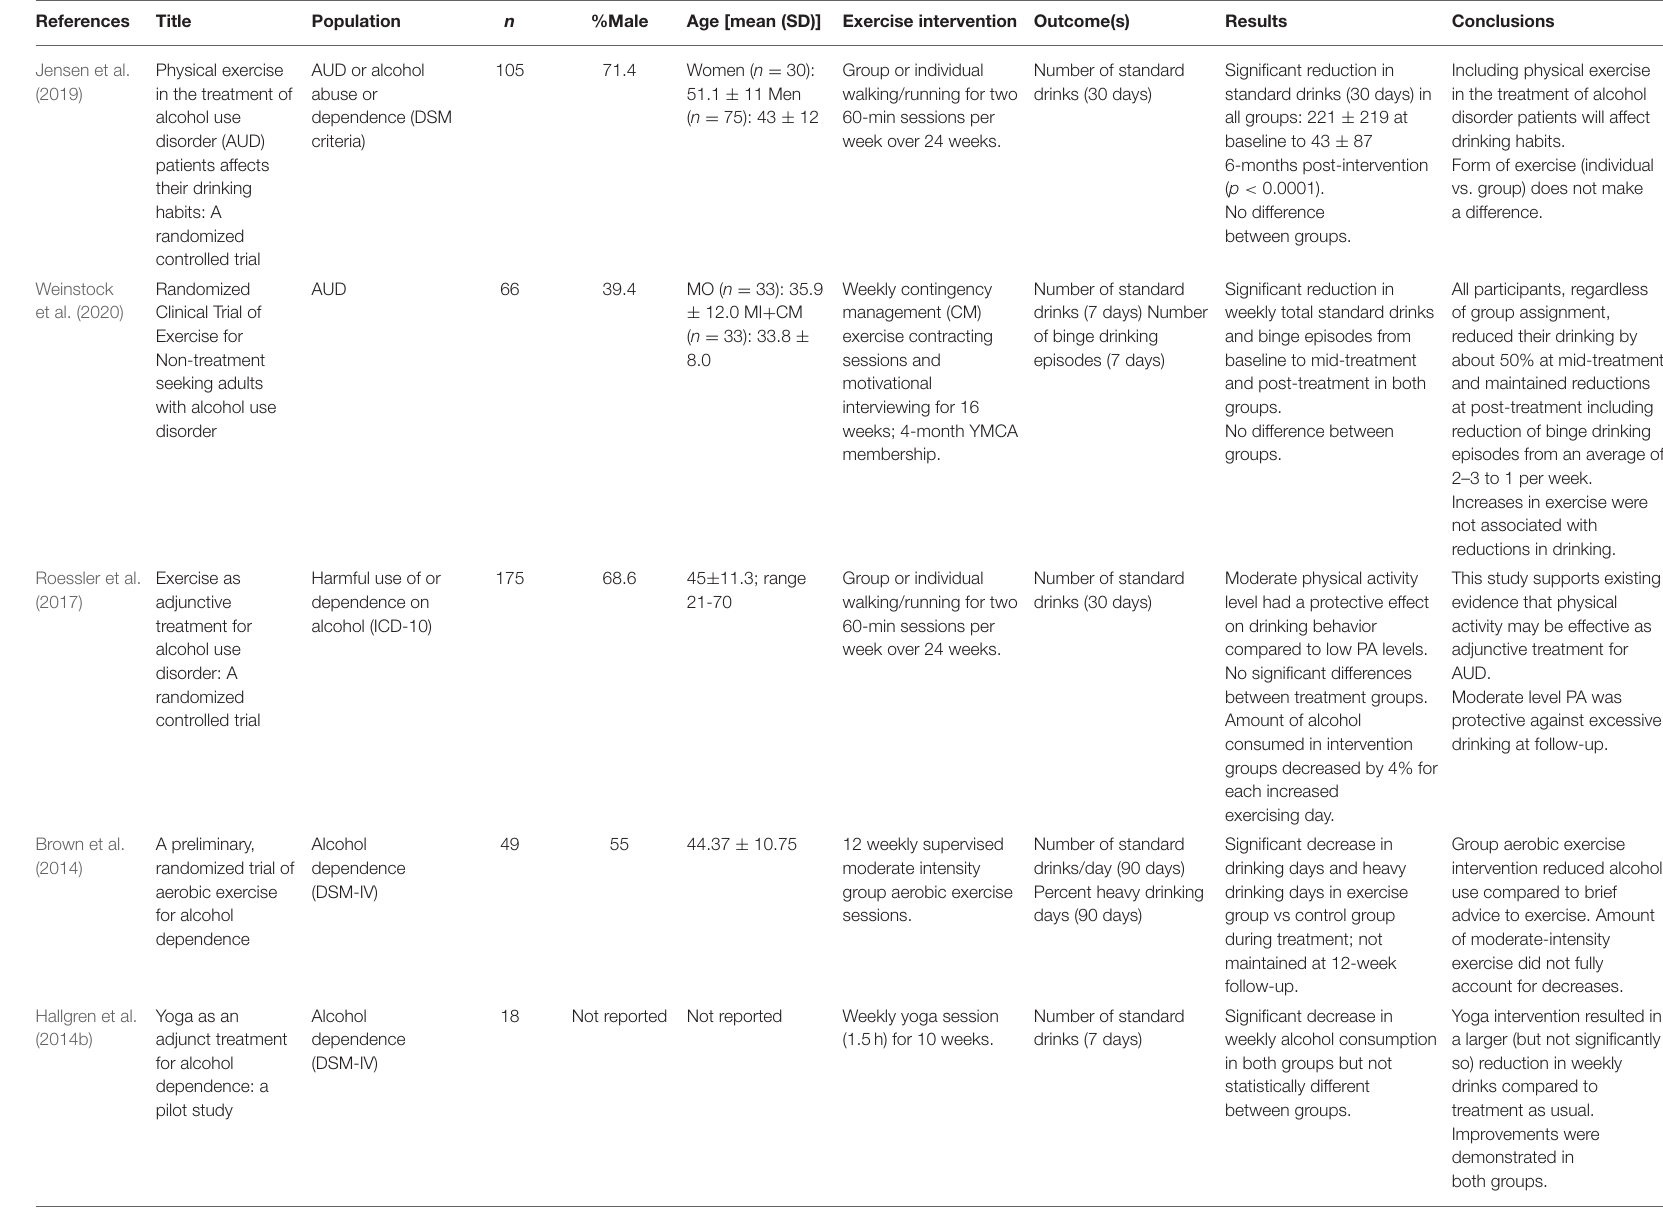
TABLE 1 | Summary of included studies and